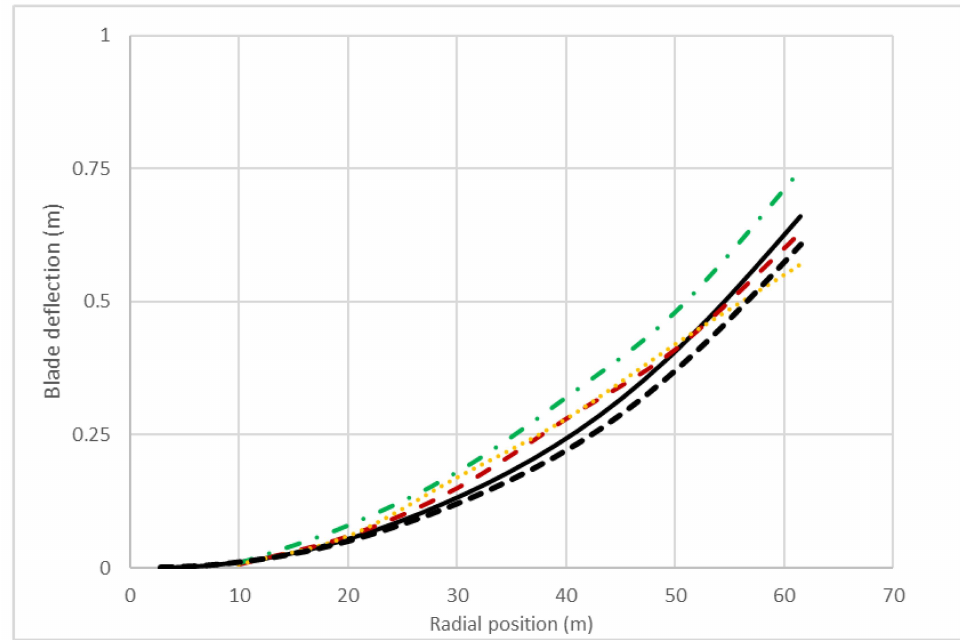
Figure 9. Blade deflection in the edge-wise due to the aerodynamic loading; The two sets of results for the present work were calculated for angular speeds Ω = 0 RPM (solid line) and 12.1 RPM (black dashed line); compared with the yellow dotted line (data adapted from [20]), the green dash-dotted line (data adapted from [32] where BEM-ABAQUS was applied) and the red dashed line (data adapted from [29] where CFD-CSD was applied).